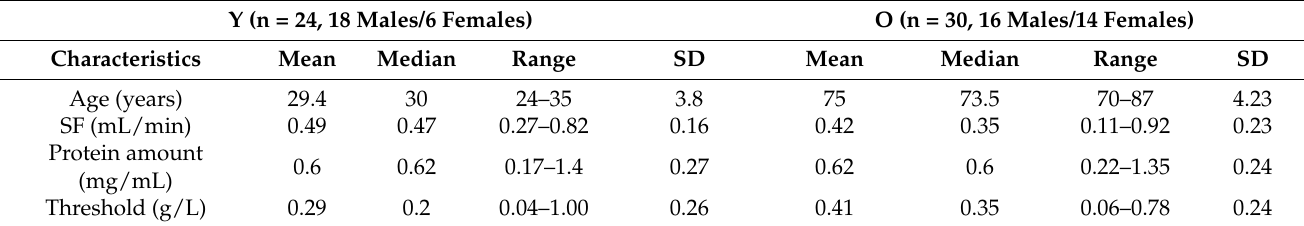
Table 1. Characteristics of the young (Y) and elderly (O) panels.